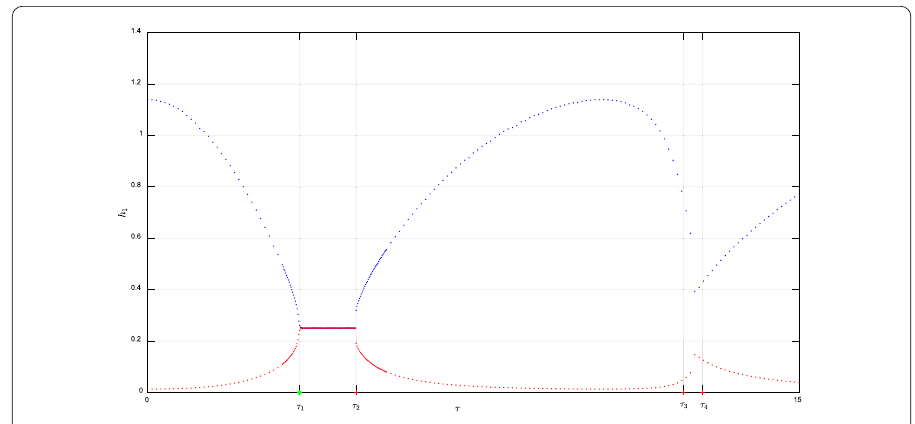
Figure 1 Bifurcation diagram of ring-structured patchy model (5.1) with α = 0 and d > A /2. There is N = 1 stability interval. Parameter values used are κ = 2, μ = 0.2, ε = 1, n = 4, γ = 0.5, α = 0, d = 0.04